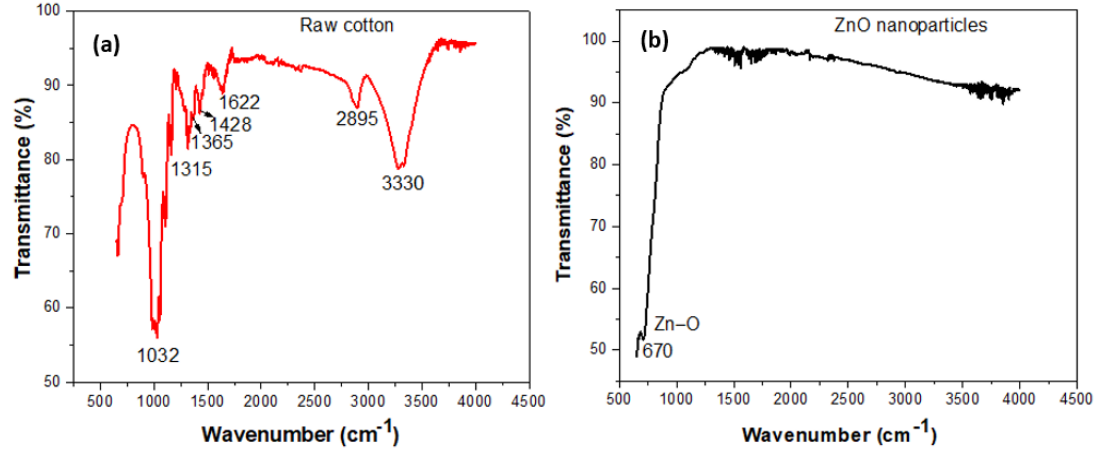
Figure 2. FTIR spectra of ( a ) raw cotton and ( b ) as-produced ZnO nanoparticles.